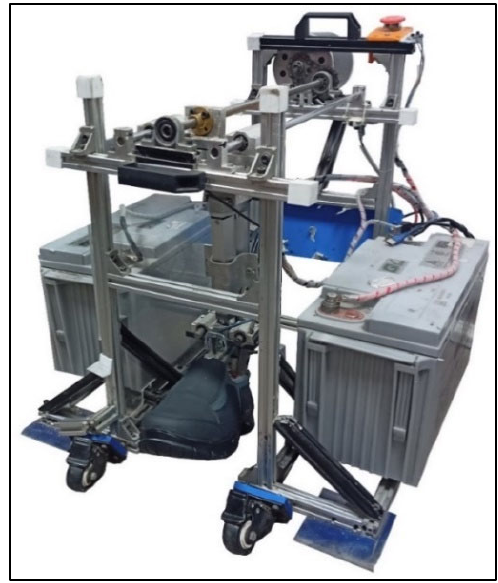
Figure 3. Whole ‐ shoe portable slip tester. Figure 3. Whole-shoe portable slip